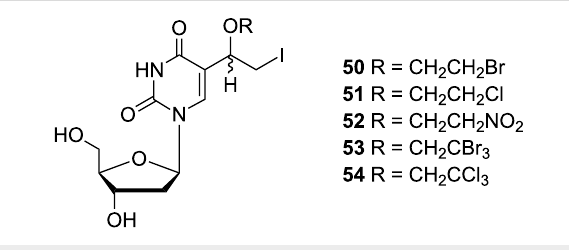
Figure 17: 5-[1-(2-Halo(or nitro)ethoxy-2-iodoethyl)]-2'-deoxyuridines 50 – 54 .